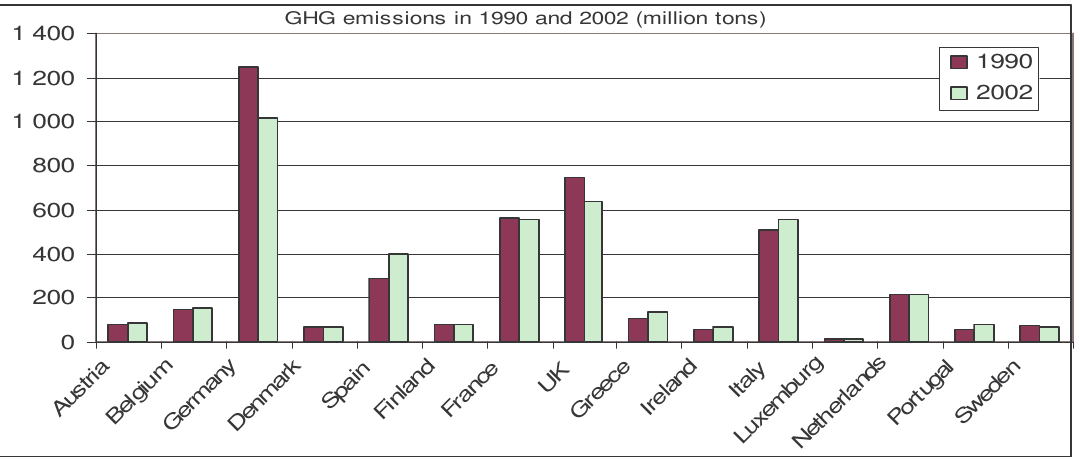
Figure 5. Trends in GHG emissions in EU15 1990-2002 source: European Environmental Agency / Statistics